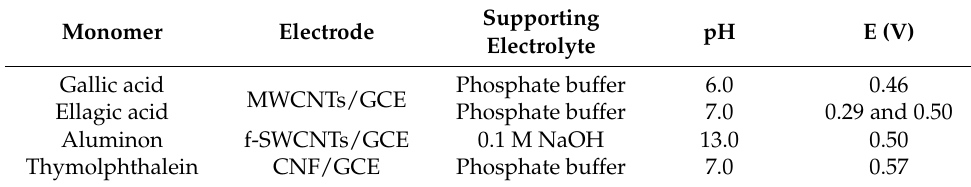
Table 1. Oxidation potentials of monomers under consideration.